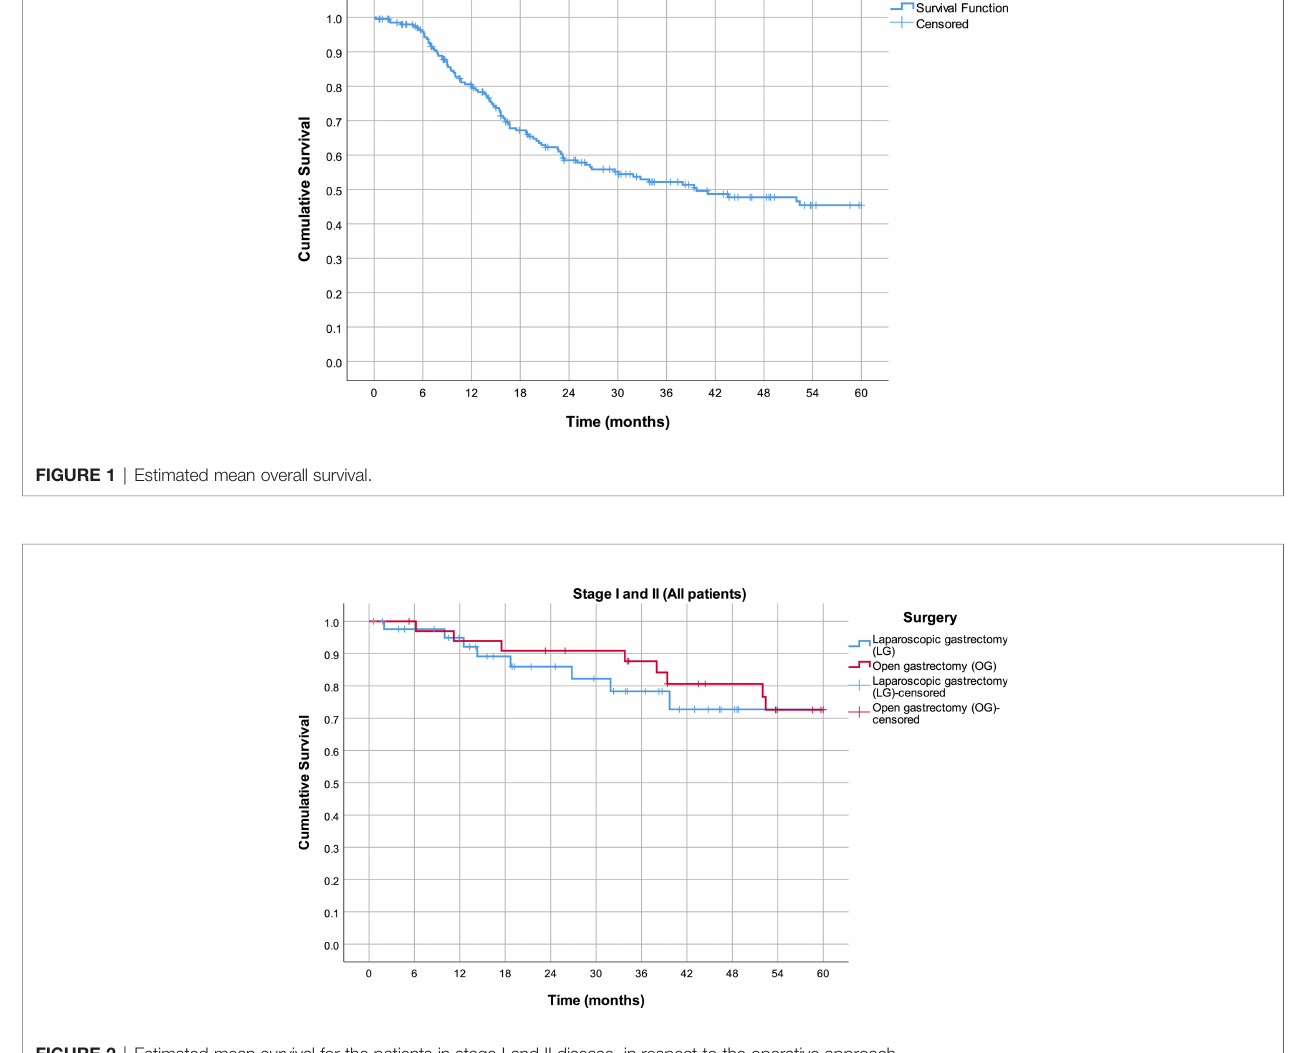
FIGURE 2 | Estimated mean survival for the patients in stage I and II disease, in respect to the operative